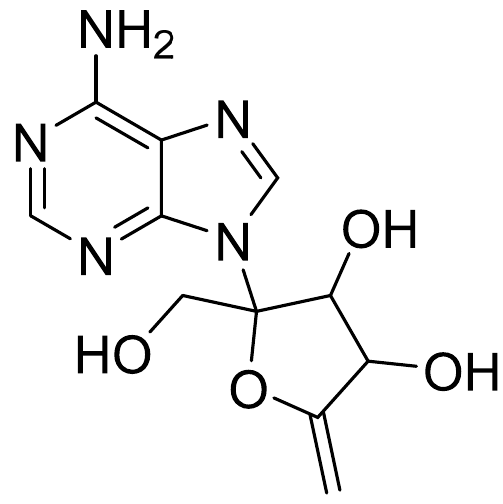
Figure 1. Structure of decoyinine.